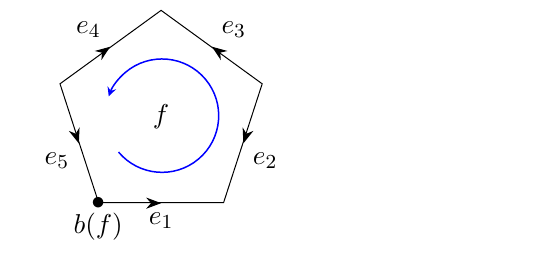
Figure 6 . Pentagonal plaquette with a chosen orientation of edges and of the face. In this case ∂f = e 5 e − 1 e 3 e − 1 e 1 . 4 2